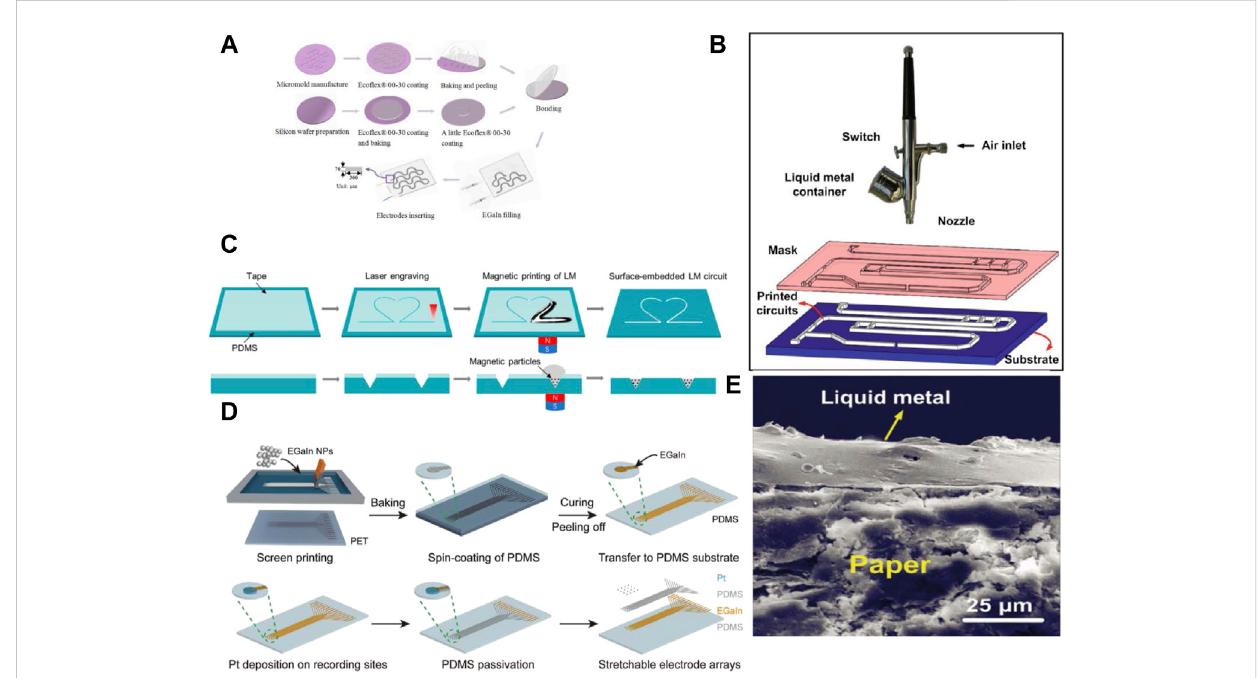
FIGURE 2 Patterning liquid metals for soft electronics. (A) Patterning of liquid metals by micro fl uidic (CHEN et al., 2020a) (B) Spray patterning of liquid metal and SEM images of spray on paper (ZHANG et al., 2013) (C) Printing liquid metals circuits by magnetic printing (ZHANG et al., 2022e) (D) Patterned liquid metal circuit by screen printing (DONG et al., 2021b) (E) Cross-section of the paper-liquid metal interface (ZHANG et al., 2013).